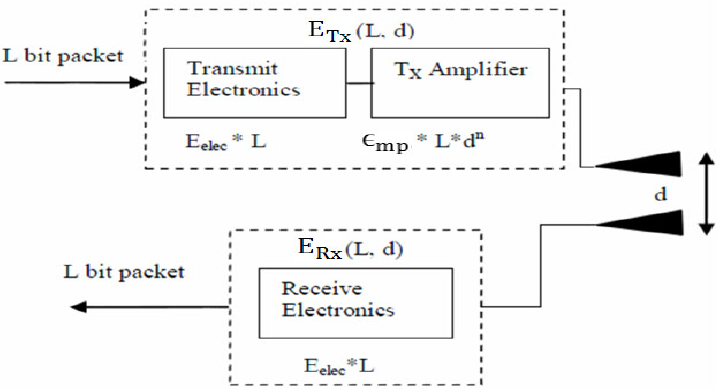
Figure 3. Radio Energy Dissipation